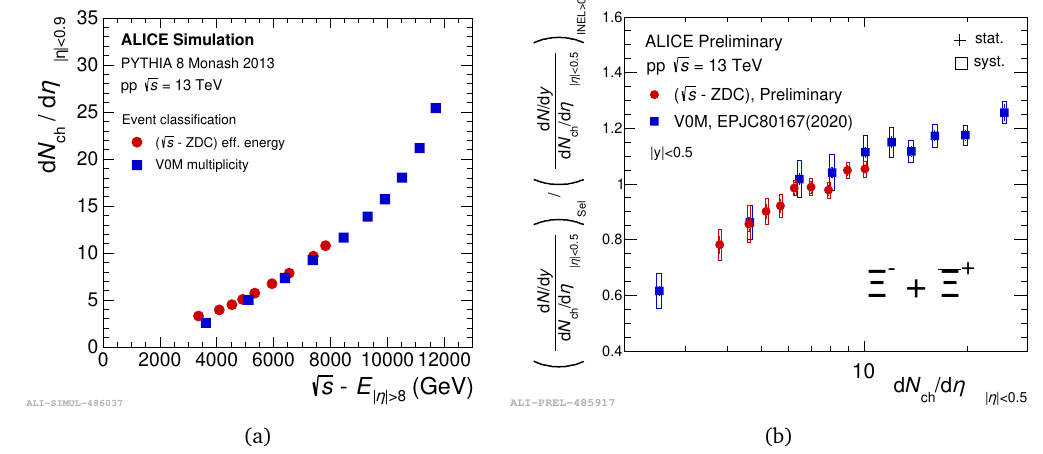
Figure 3: (a) Multiplicity and effective energy correlation in PYTHIA 8 using V0 and ZDC event classes. (b) Ratio of Ξ yields to the charged-particle multiplicity (self- normalized to INEL > 0) as a function of particle production at midrapidity, using V0 and ZDC standalone